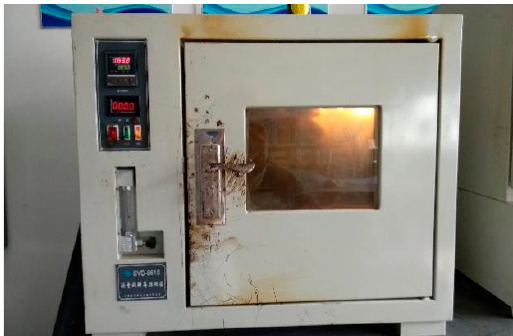
Figure 1. Rolling thin-film oven test (RTFOT).